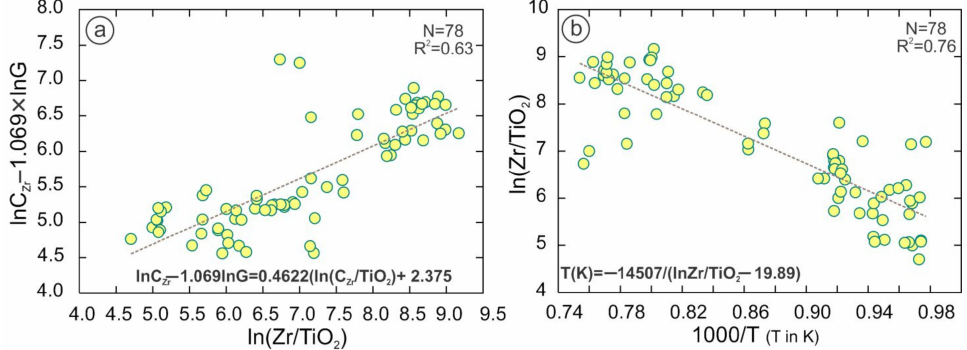
Figure 11. ( a , b ) ln(C Zr /TiO 2 ) in bulk composition correlate to lnC Zr − 1.069lnG and